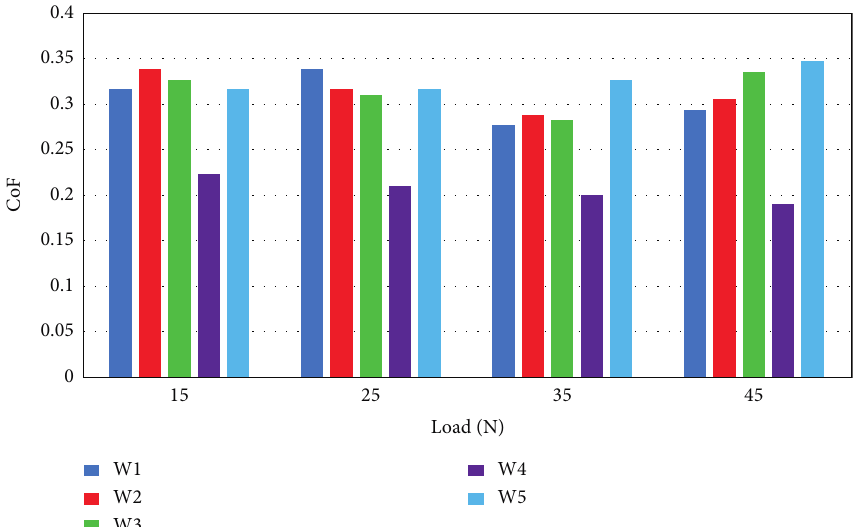
Figure 10: Variation on the coefficient of friction (CoF) of composites for 1500m sliding distance.